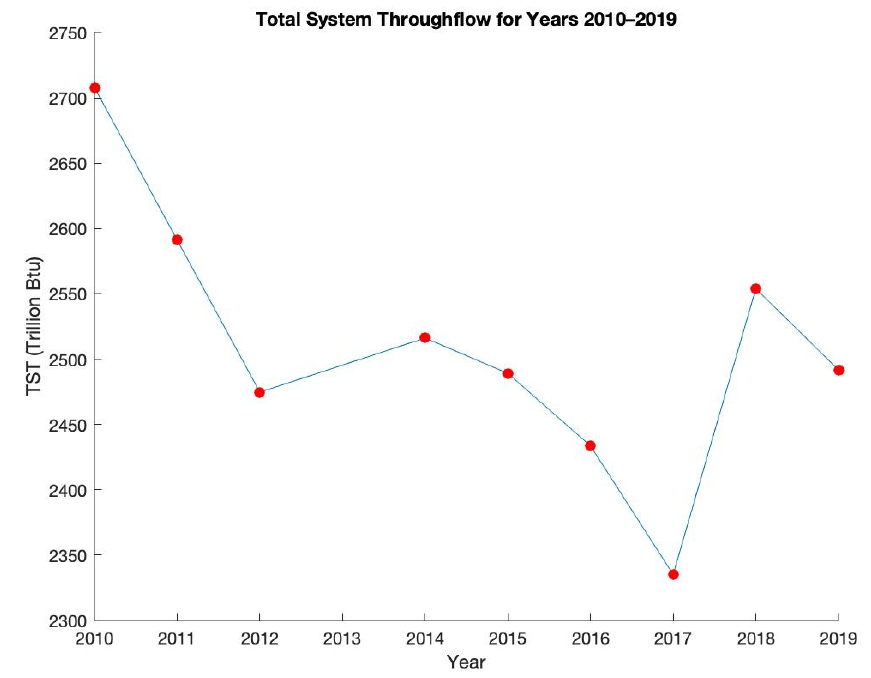
Figure 3. TST for Maryland’s energy industry from 2010–2019. Data from 2013 were not accessible.